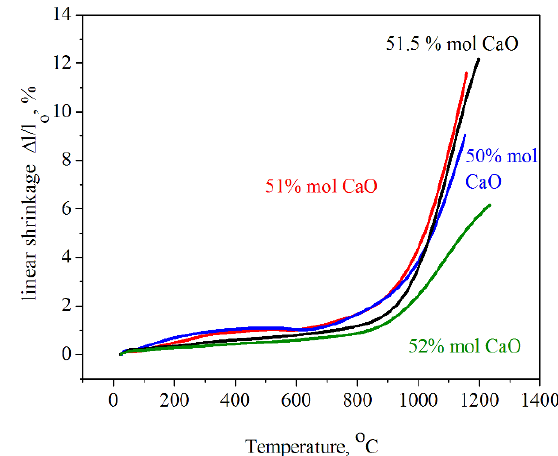
Figure 3. Dilatometric curves recorded for investigated CaZrO based